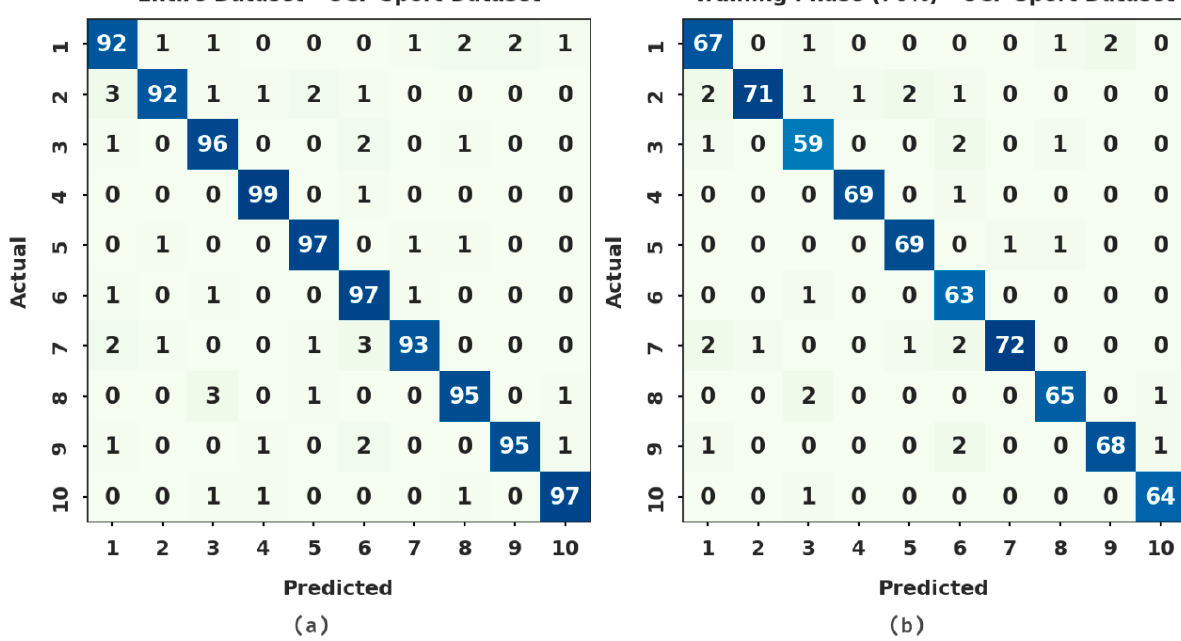
Table 4. Comparative 𝑎𝑐𝑐𝑢 (cid:3052) analysis of QWSA-HDLAR model on KTH dataset.